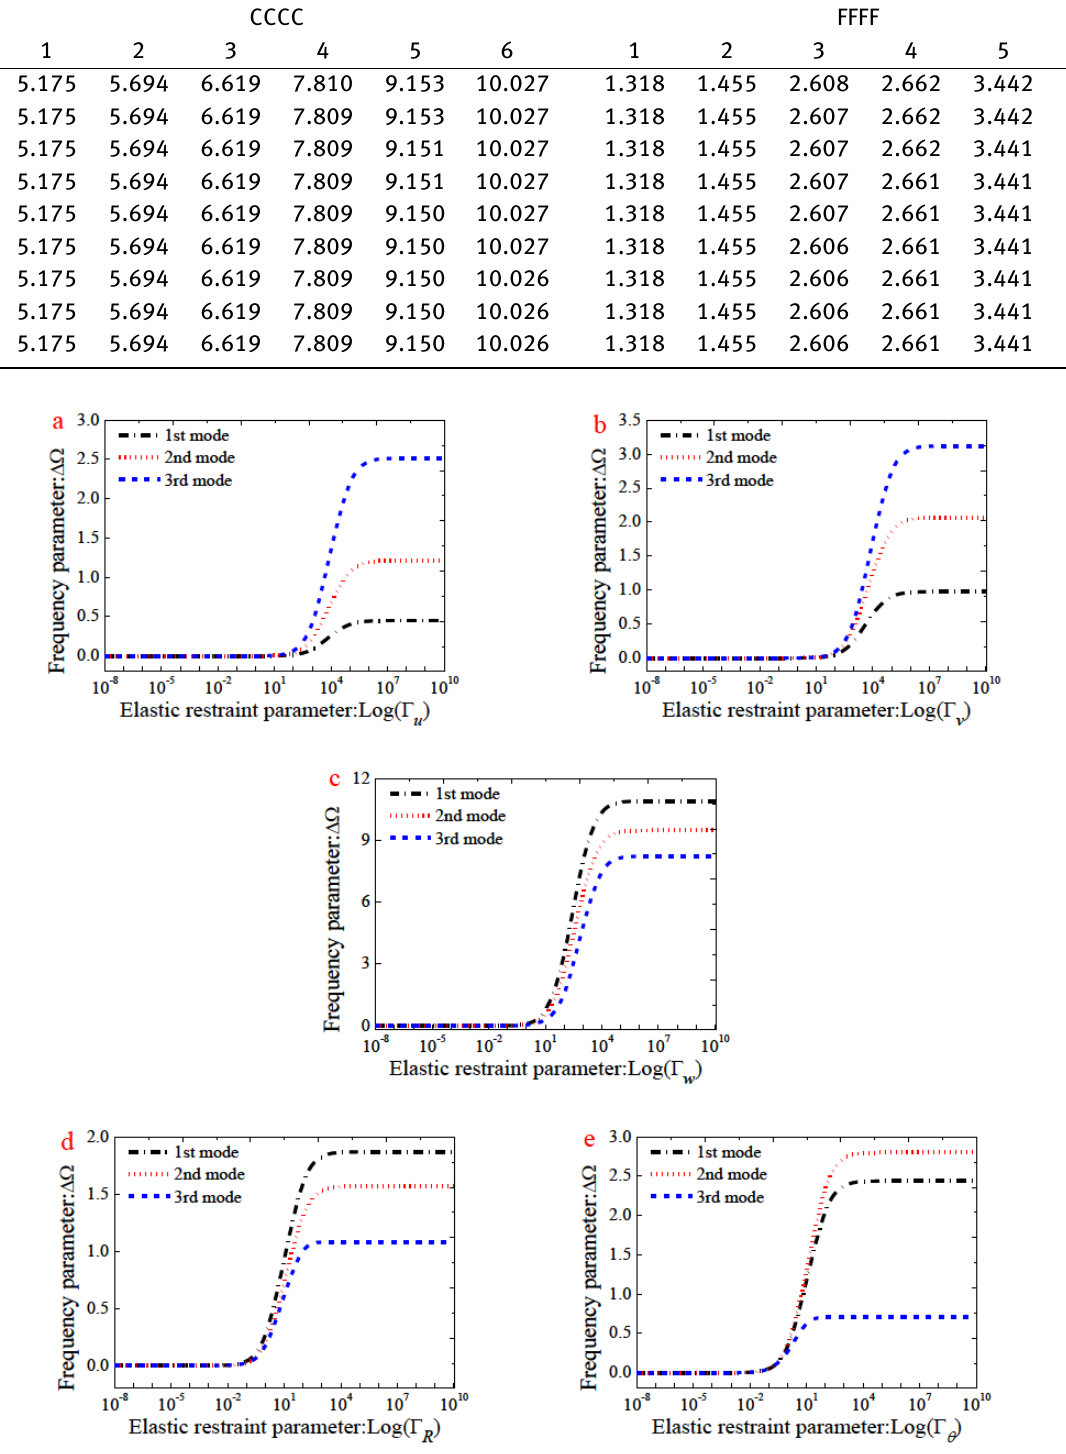
Figure 2: Variation of the frequency parameters ∆Ω versus the elastic restraint parameters Γ λ for a two-layered, [0 o /90 ∘ ], unsymmetrically laminated annular sector plate: (a) Γ u ; (b) Γ v ; (c) Γ w ; (d) Γ R ; and (e) Γ